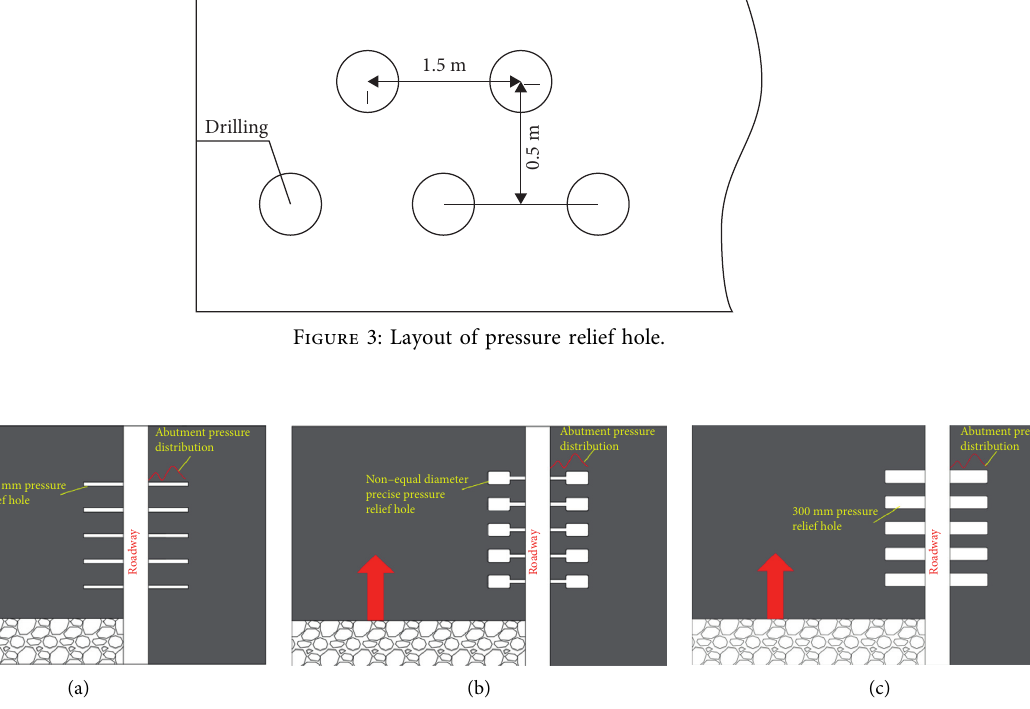
Figure 4: Schematic diagram of pressure relief hole layout. (a) 100mm pressure relief hole. (b) Nonequal diameter precision pressure relief hole. (c) 300mm pressure relief